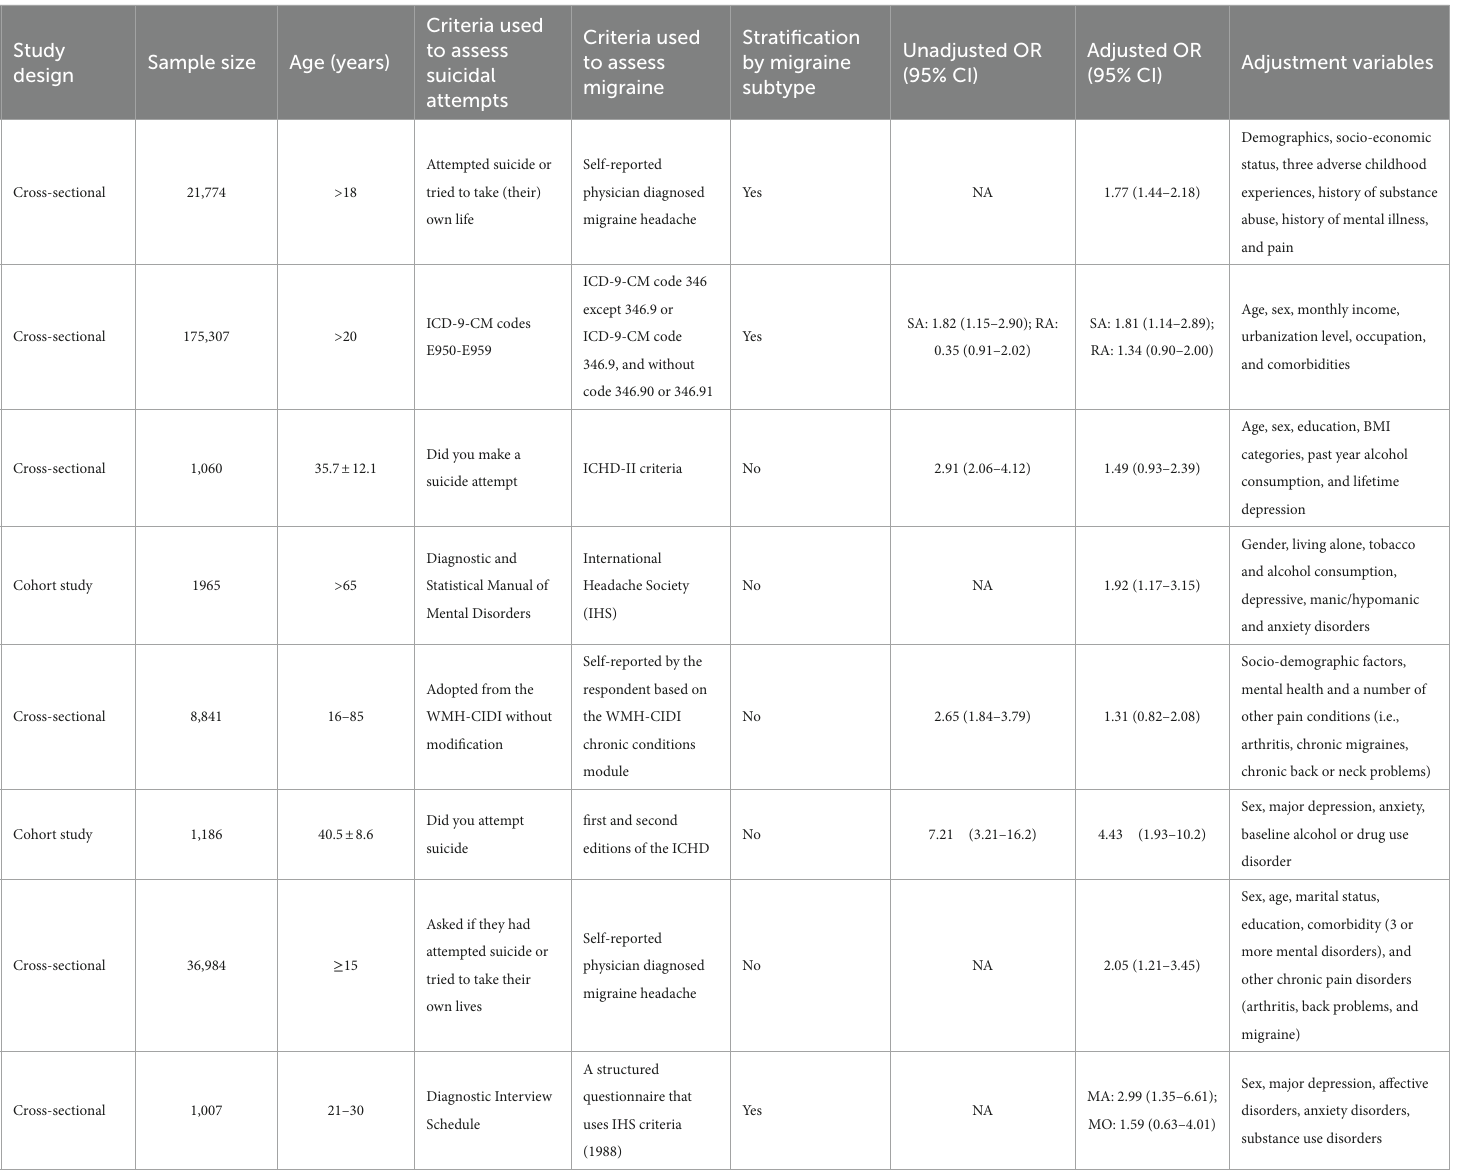
TABLE 2 Description of studies about suicidal attempts and migraine included in the